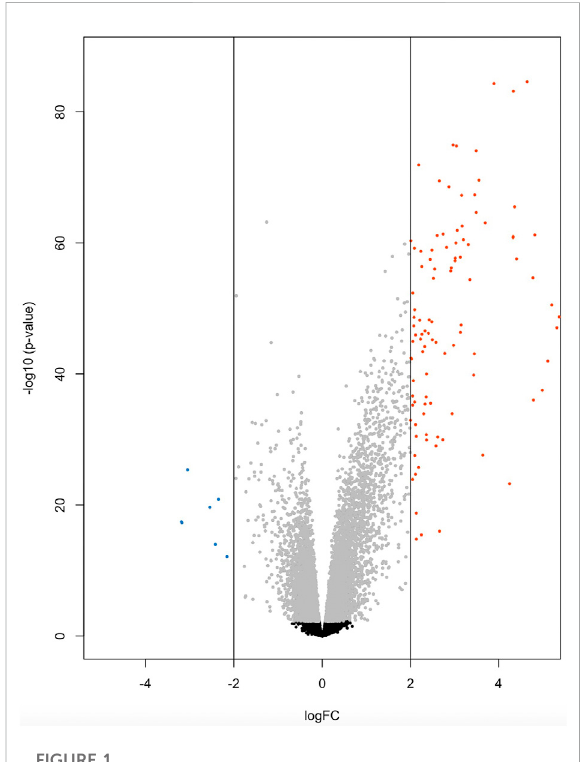
FIGURE 1 Volcano plot of 7 down-regulated genes (blue) and 94 up- regulated genes (red) for BRD